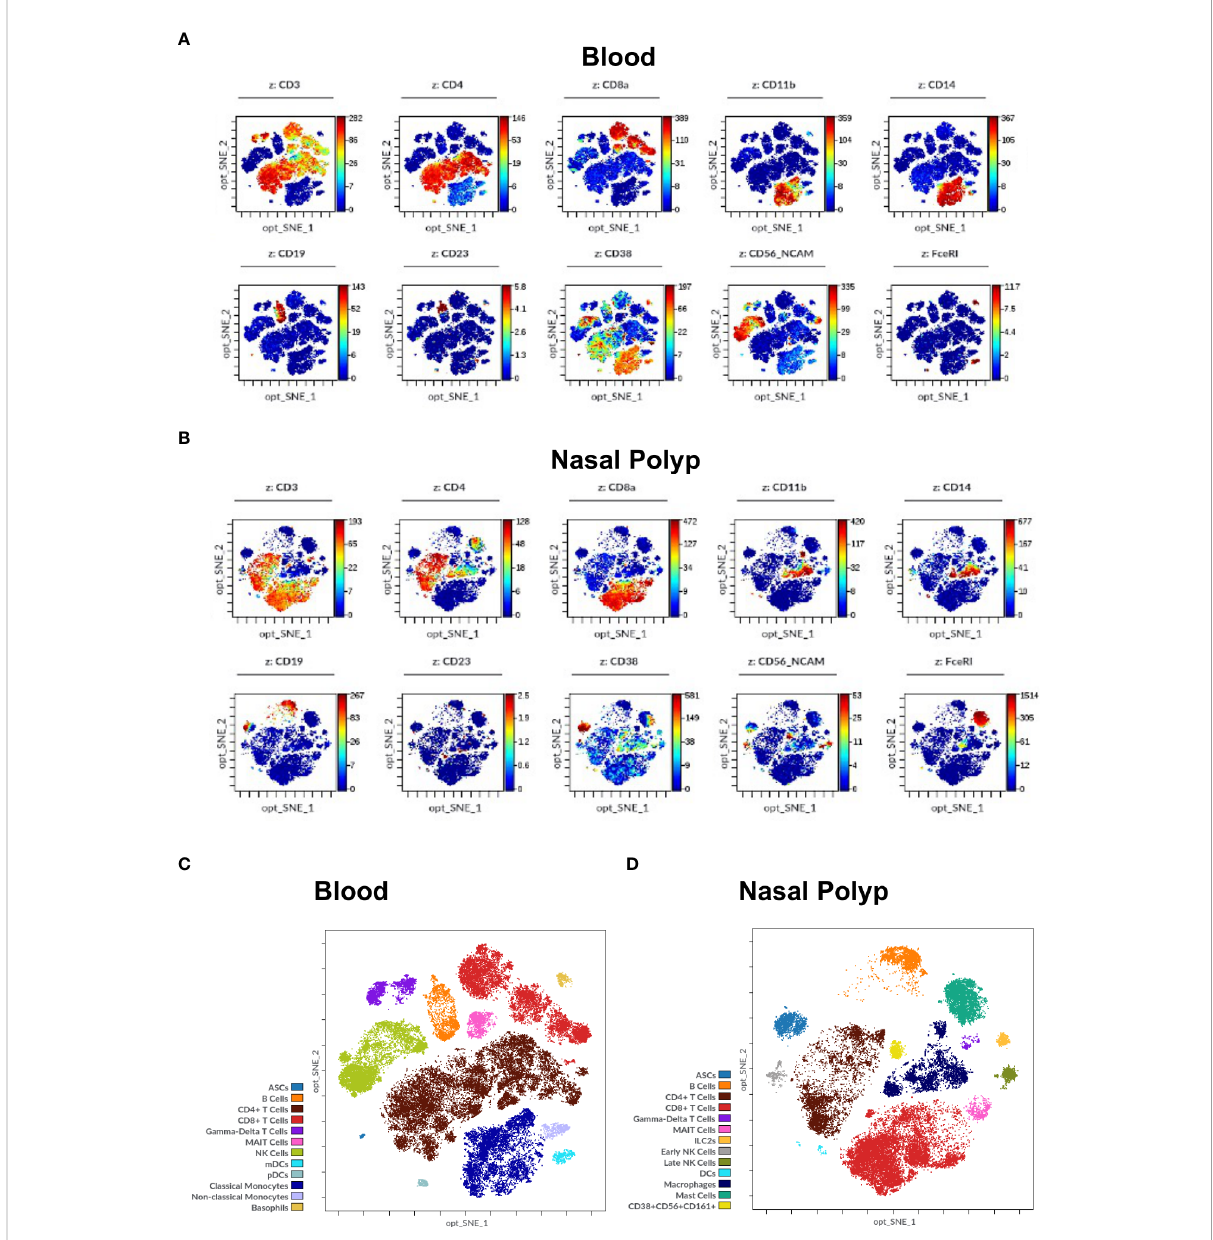
FIGURE 5 Immune cell markers in human blood and nasal polyp. (A, B) Opt-SNE plots show selected markers of the modi fi ed Maxpar Direct Immune Pro fi ling Assay (MMDIPA panel), namely CD3, CD4, CD8a, CD11b, CD14, CD19, CD23, CD38, CD56, and Fc ϵ RI in (A) Blood and (B) nasal polyp single cell suspensions acquired in Helios ® (Standard BioTools). The scales vary throughout the plots according to the intensity presented by the markers. Plots shown are representative of three independent experiments. (C) Identi fi cation of immune cell populations in blood using mass cytometry. Opt-SNE show manually selected cell populations: Antibody Secreting Cells (ASCs), B Cells, CD4+ T Cells, CD8+ T Cells, Gamma- Delta T Cells, Mucosal-associated invariant T (MAIT) Cells, Natural Killer (NK) Cells, Myeloid Dendritic Cells (mDCs), Plasmacytoid Dendritic Cells (pDCs), Classical Monocytes, Non-classical Monocytes, and Basophils. (D) Identi fi cation of immune cell populations in nasal polyp using mass cytometry. Opt-SNE s show manually selected cell populations: ASCs, B Cells, CD4+ T Cells, CD8+ T Cells, Gamma-Delta T Cells, MAIT Cells, Type 2 Innate Lymphoid Cells (ILC2s), NK Cells, Dendritic Cells (DCs), Macrophages, Mast Cells, CD38+CD56+CD161+ Cells. The manually annotated populations in (C) and (D) are overlaid as a